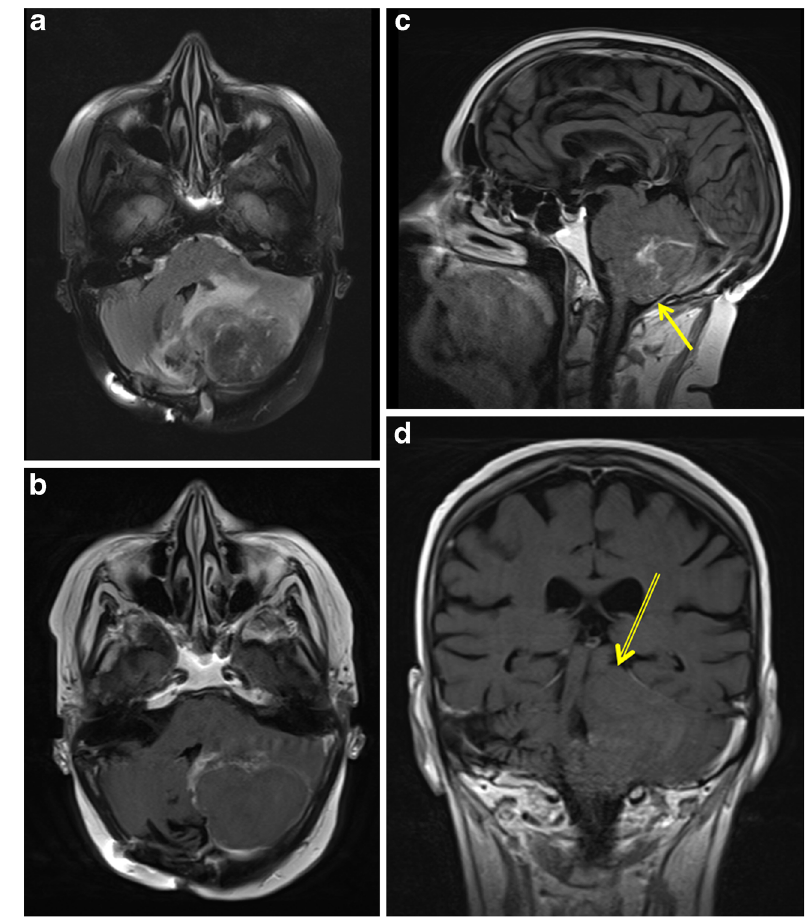
Fig. 11 Cerebral herniation secondary to a cerebellar brain metastasis in a 51-year-old woman non-small lung cancer patient with a history of pancranial radiation therapy for brain metastases. Axial FLAIR ( a ) and axial T1-weighted image after intravenous gadolinium contrast administration ( b ) show a peripheral enhancing mass in the left cerebellar hemisphere with peritumoural oedema resulting in a midline shift and compression of the fourth ventricle. Sagittal T1-weighted contrast-enhanced image ( c ) demonstrates herniation of the left cerebellar tonsil trough the foramen magnum ( yellow arrow ). Coronal T1-weighted contrast-enhanced images shows an ascending transtentorial herniation with displacement of cerebellar tissue through the tentorial notch ( double yellow arrow